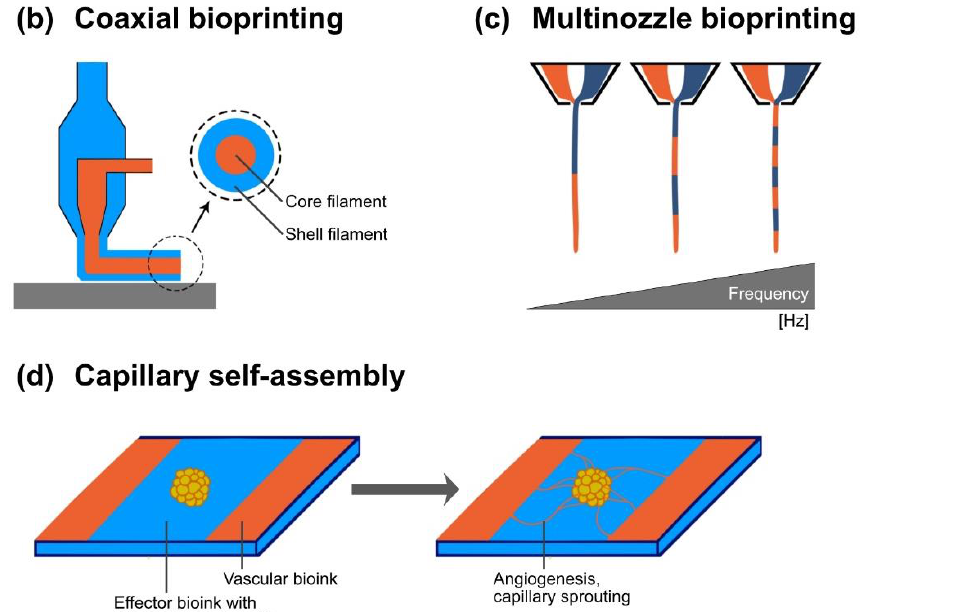
Figure 3. Bioprinting strategies to fabricate vascularization. ( a ) Embedded bioprinting into a (func- tional) viscoplastic support bath. Viscoplastic microsphere fluids present self-healing properties with fluid-like regions and shear-thinning effects directly along the moving microextrusion nozzle. Direct printing and subsequent in situ crosslinking of vascular bioink enables fabrication of free-form struc- tures with high shape fidelity. Crosslinking can be initiated by the support bath, e.g., chemically. The microextrusion and subsequent dissolution of sacrificial bioinks after previous curing of the functional support bath can create hollow channel networks. Such networks can be perfused with endothelial cell solution for cell adherence and formation of an endothelial lining. ( b ) Coaxial microextrusion bioprinting using concentric nozzles enables simultaneous printing with different bioinks with a core–shell or layered cross-section. ( c ) Multinozzle bioprinting technology with fast high-frequency switching can fabricate continuous filaments from multiple materials. ( d ) Self-assembly of capillaries from bioprinted vessel-like structures. The cultivation of bioprinted tissue constructs can provide an environment that further enhances vascularization by self-assembly. Therefore, relevant angiogenic signals might need to be integrated in bioinks before